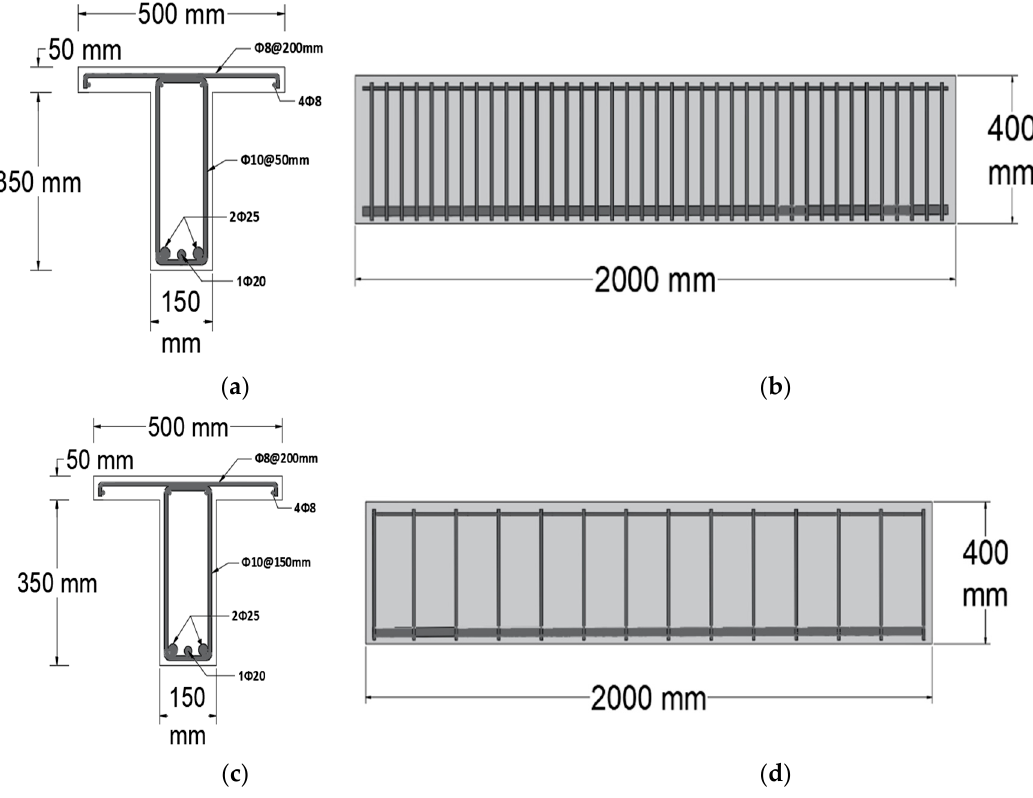
Figure 1. Beams geometry: ( a ) cross section of group (A); ( b ) longitudinal section of group (A); ( c ) cross section of group (B); ( d ) longitudinal section of group (B).